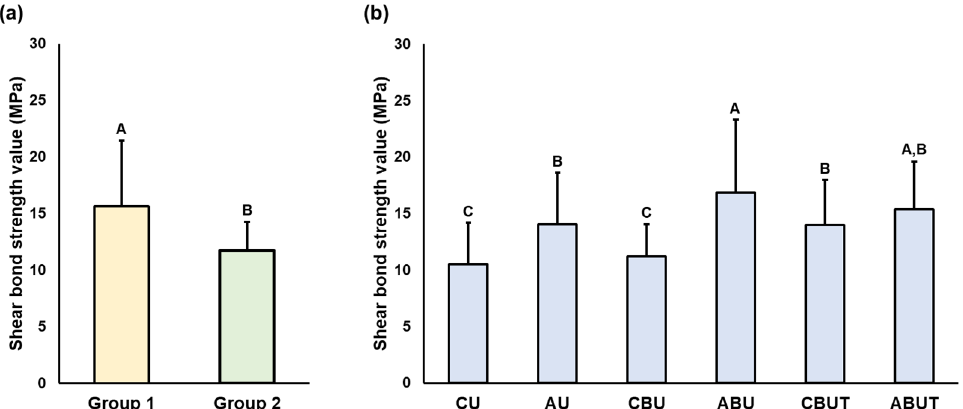
Figure 3. Results of the two-way ANOVAs of SBS after thermocycling ( a ) between Groups 1 and 2 and ( b ) between the groups with different adhesion conditions. Uppercase letters indicate significant differences. Data are the means and SD values.